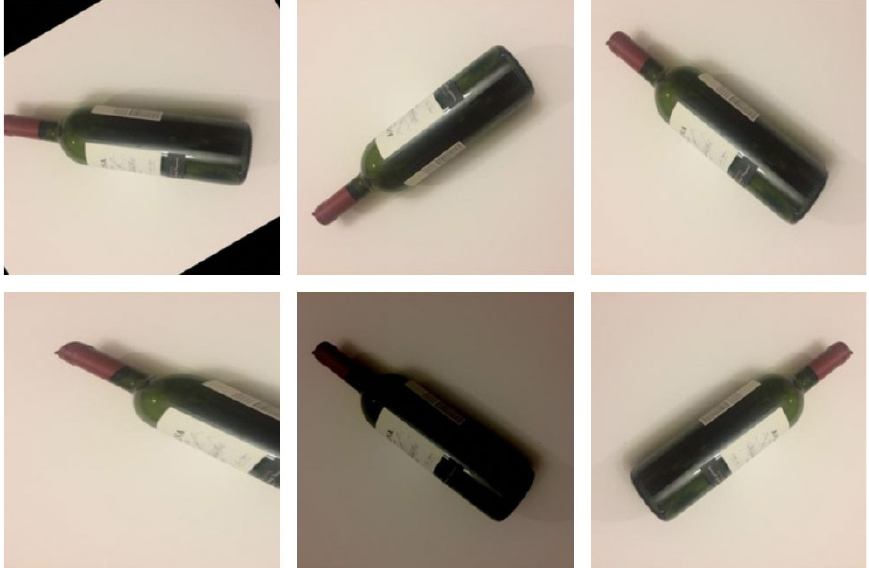
Fig. 2. Augmented images of a sample from glass class